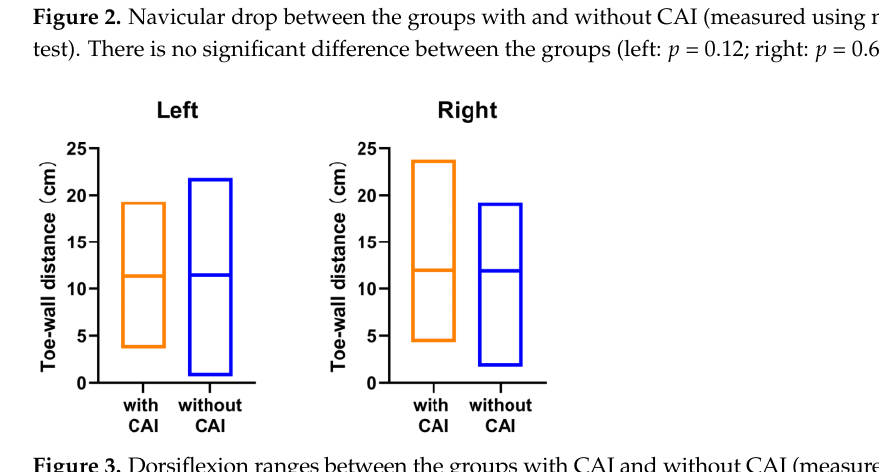
Figure 3. Dorsiflexion ranges between the groups with CAI and without CAI (measured using dor- siflexion lunge test). There is no significant difference between the groups (left: p = 0.82; right: p = 0.88). Table 3. Ankle sprain history and prevalence of chronic ankle instability (CAI) in different sports.